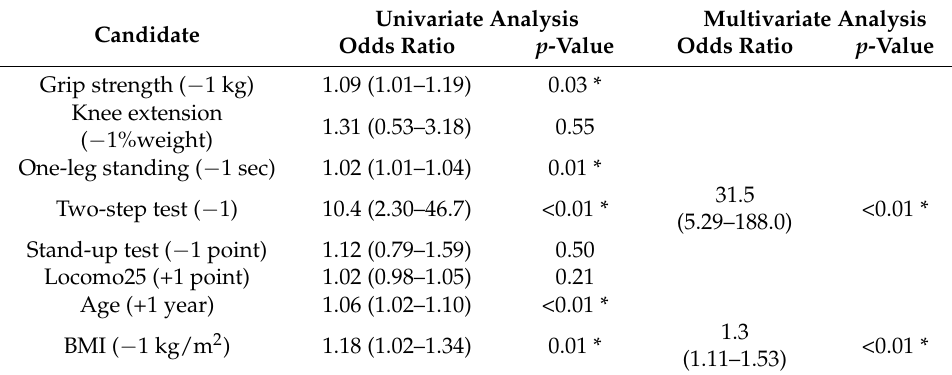
Table 5. Physical performance tests related to